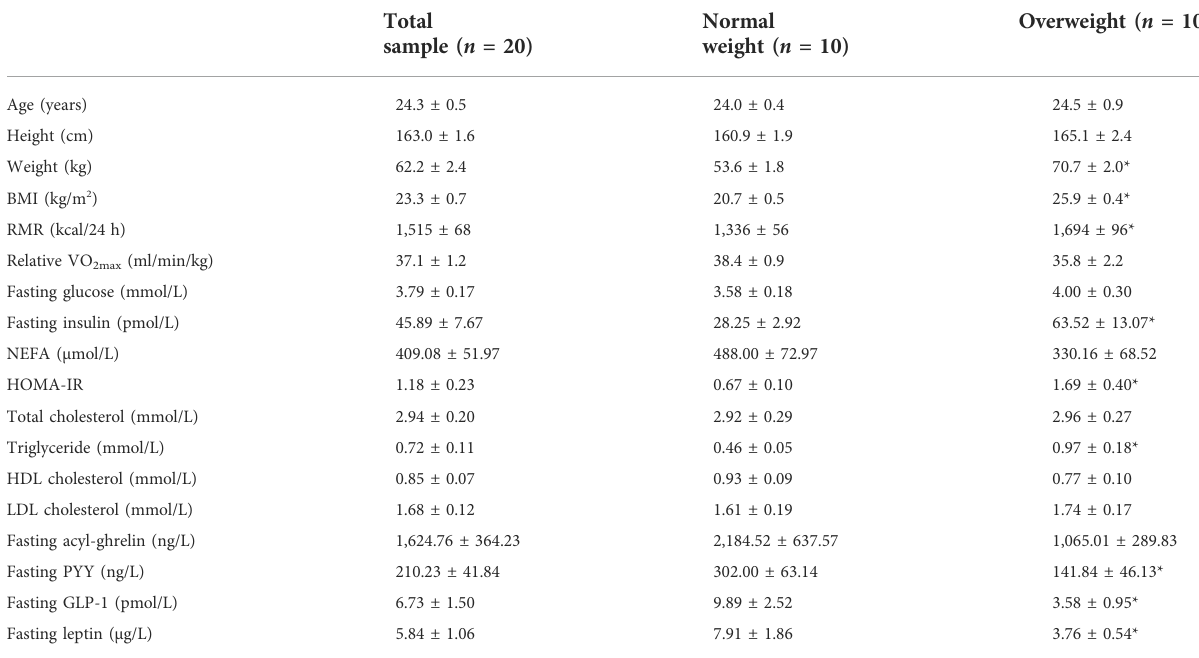
TABLE 1 Participant